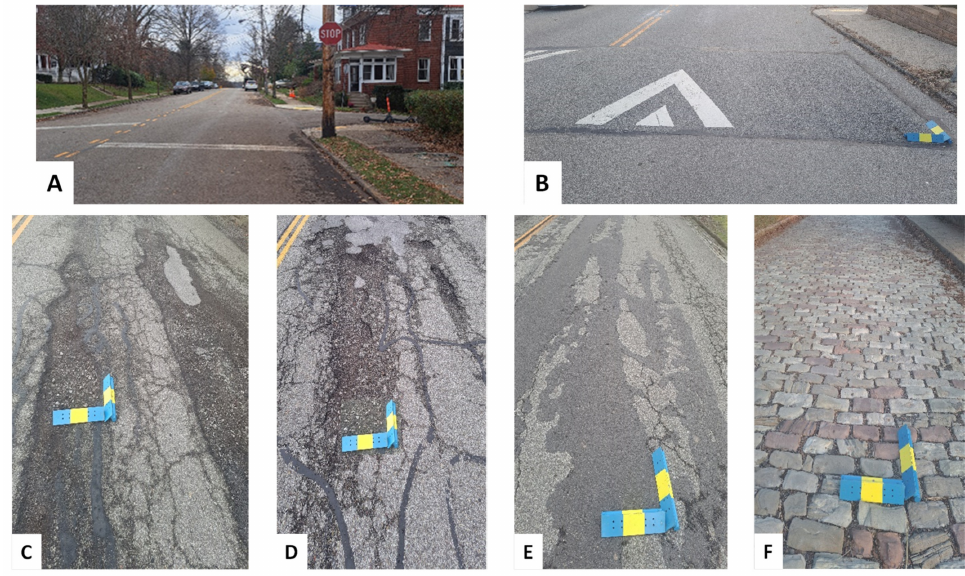
Figure 5. Vibration tests driving tasks: ( A ) Sudden Brake, ( B ) Speedbump, ( C ) Pothole 1, ( D ) Pothole 2, ( E ) Uneven surface, ( F ) Cobblestone up/down hill. Blue/yellow object 16-inch-long for